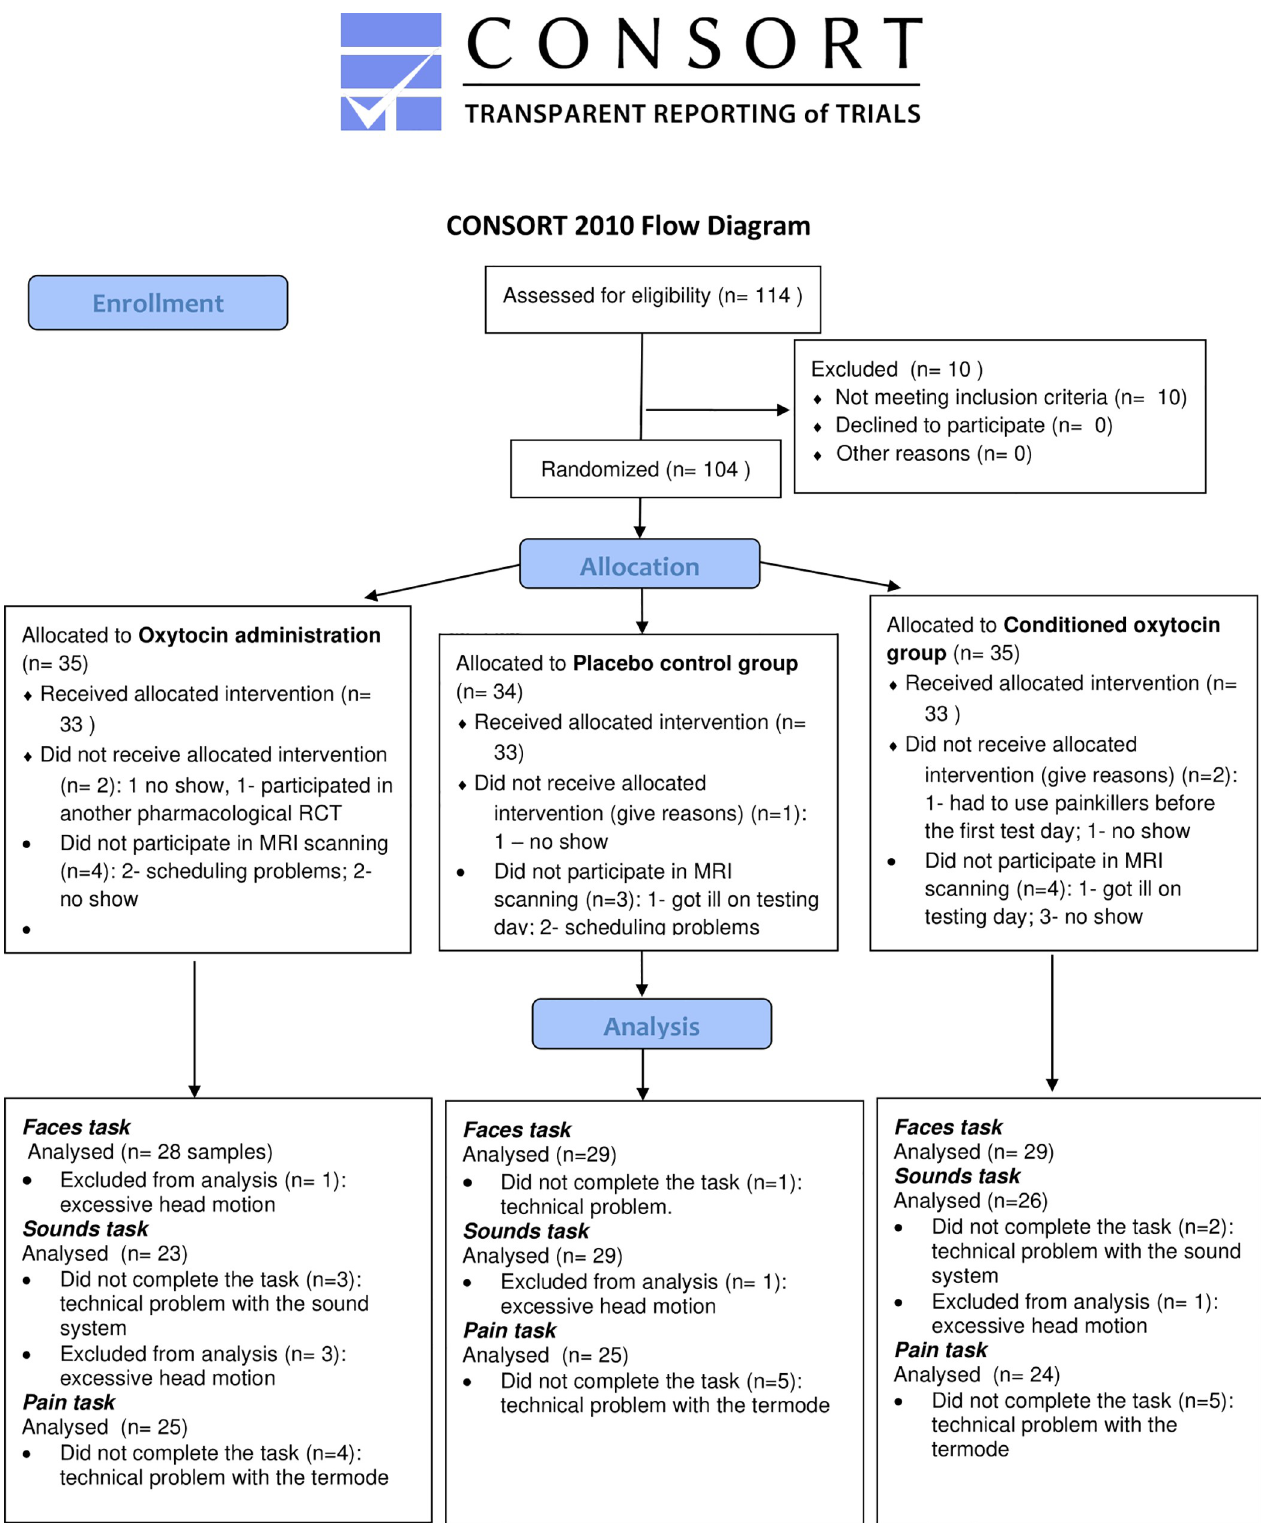
Fig 1. CONSORT flow diagram.